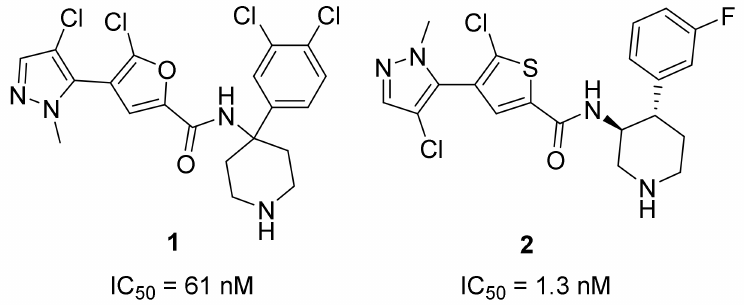
Figure 2. Structures of pyrazole-based Akt inhibitors and their IC 50